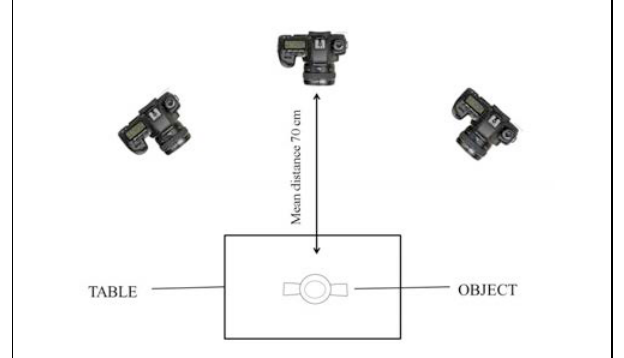
Figure 1. Set arrangement for the photogrammetric survey.